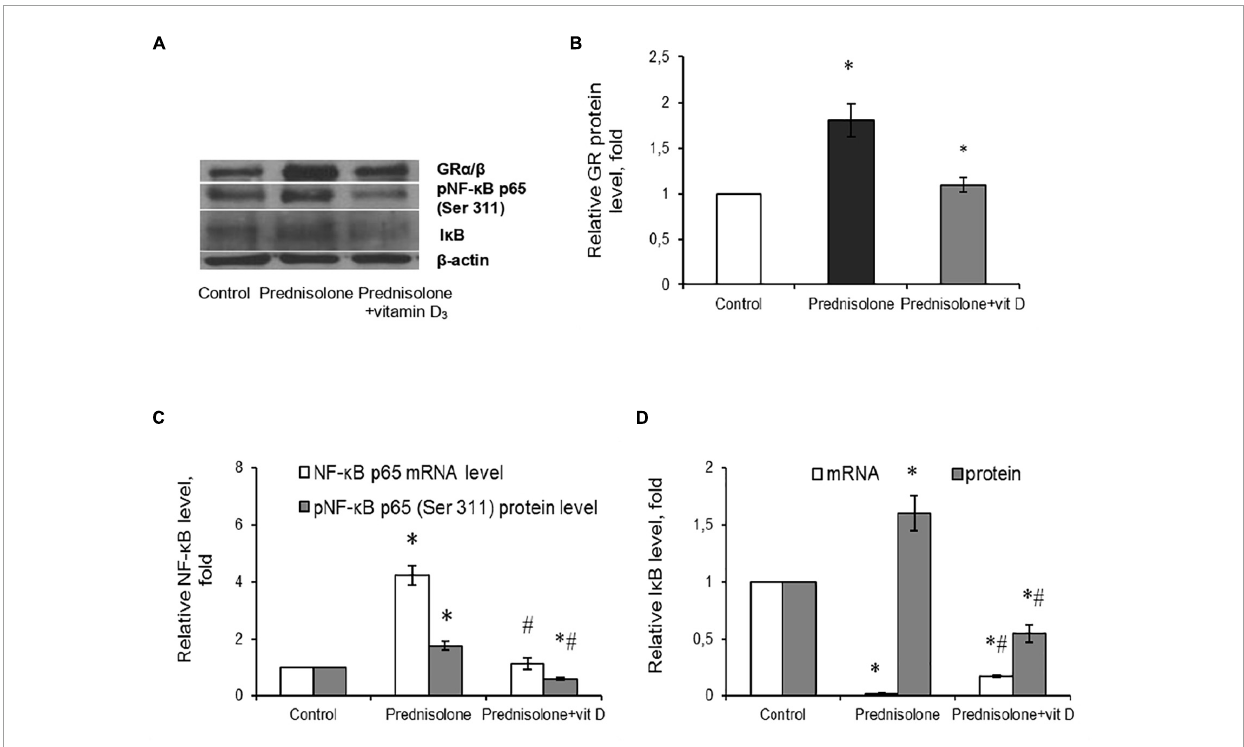
FIGURE9 Glucocorticoid receptor level and NF- κ B/I κ B pathway in brain tissue after prednisolone and vitamin D 3 administration. Glucocorticoid receptor protein (A,B) level was determined by western blot analysis. NF- κ B signaling was characterized based on the Nf- κ b p65 mRNA level (C) , NF- κ B p65 phosphorylated at Ser 311 (Western blot) (A,C) and I κ B protein (A,D) and mRNA (D) levels in rat brain tissue of three animal groups: 1—control; 2—prednisolone administration; 3—prednisolone and vitamin D 3 administration ( n = 8 rats/group). Protein level was normalized to β -actin and mRNA levels—to Gapdh expression. All data are presented as mean ± SD of three independent experiments done in triplicate; ∗ p < 0.05 denotes significance compared with control, # p < 0.05 denotes significance compared with prednisolone administration (one-way ANOVA, Tukey’s post-hoc